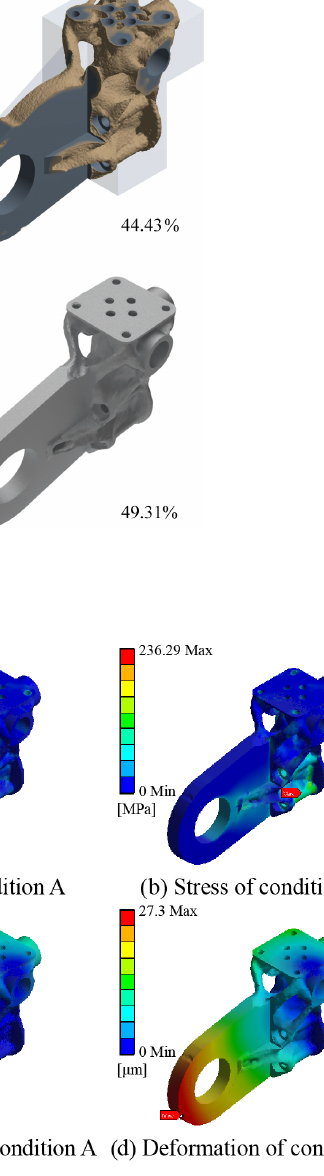
Figure 10. Stress and deformation of the pull